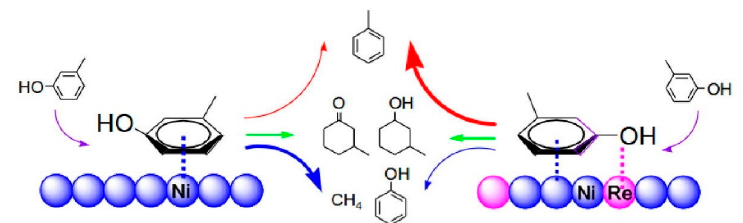
Figure 13. Proposed mechanism for selective deoxygenation of m-cresol over bimetallic Ni-Re catalysts for ref [70] .